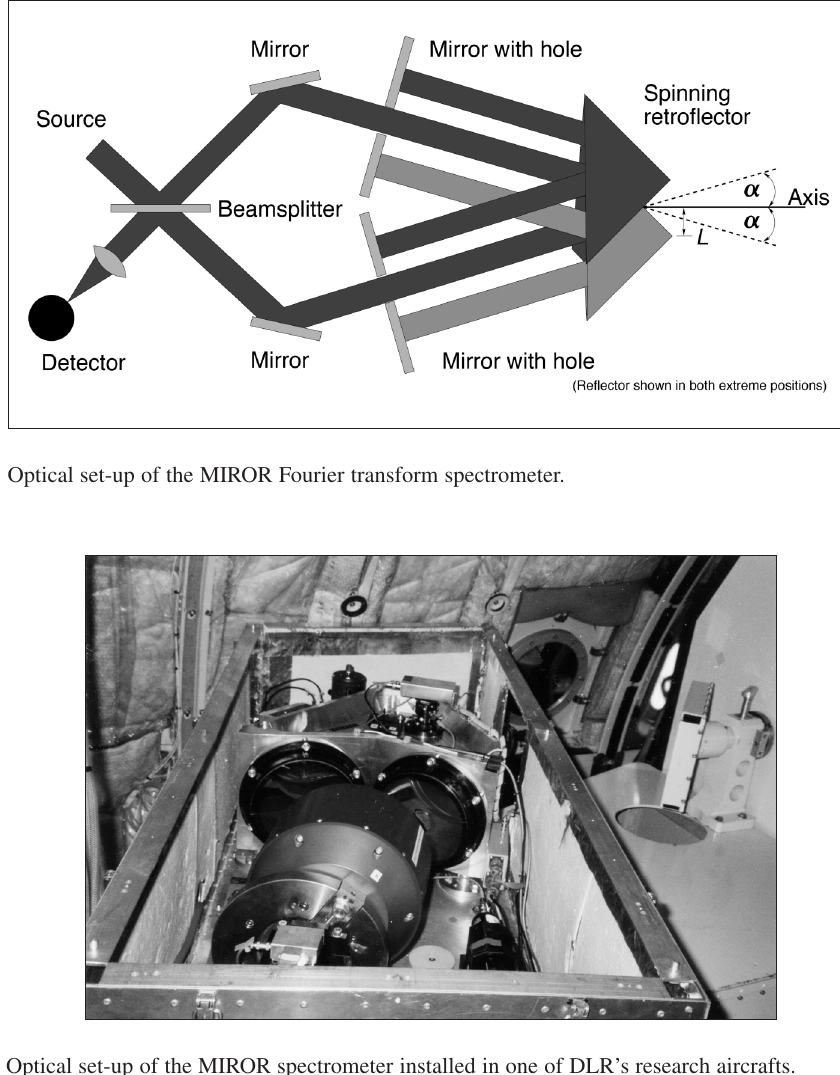
Fig. 2. Optical set-up of the MIROR spectrometer installed in one of DLR’s research aircrafts.